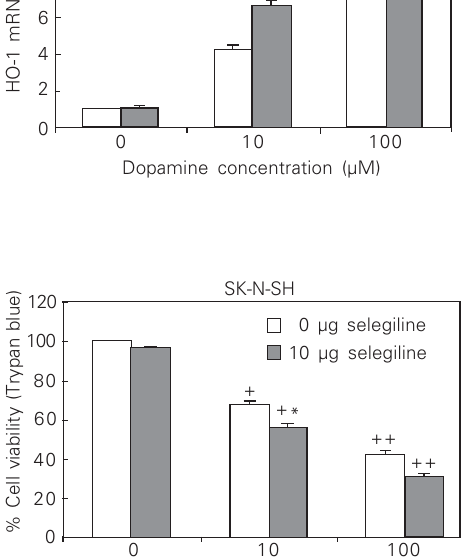
Figure 4. Effect of 10 µM selegi- line on the survival of SK-N-SH cells exposed to dopamine. Data are reported as means ± SEM (N = 5). Statistical analyses were by two-way ANOVA with pairwise comparisons. + P < 0.05 and ++ P < 0.001 com- pared with 0 µM selegiline at 0 µM dopamine; *P < 0.05 com- pared with 0 µM selegiline at 10 µM or 100 µM